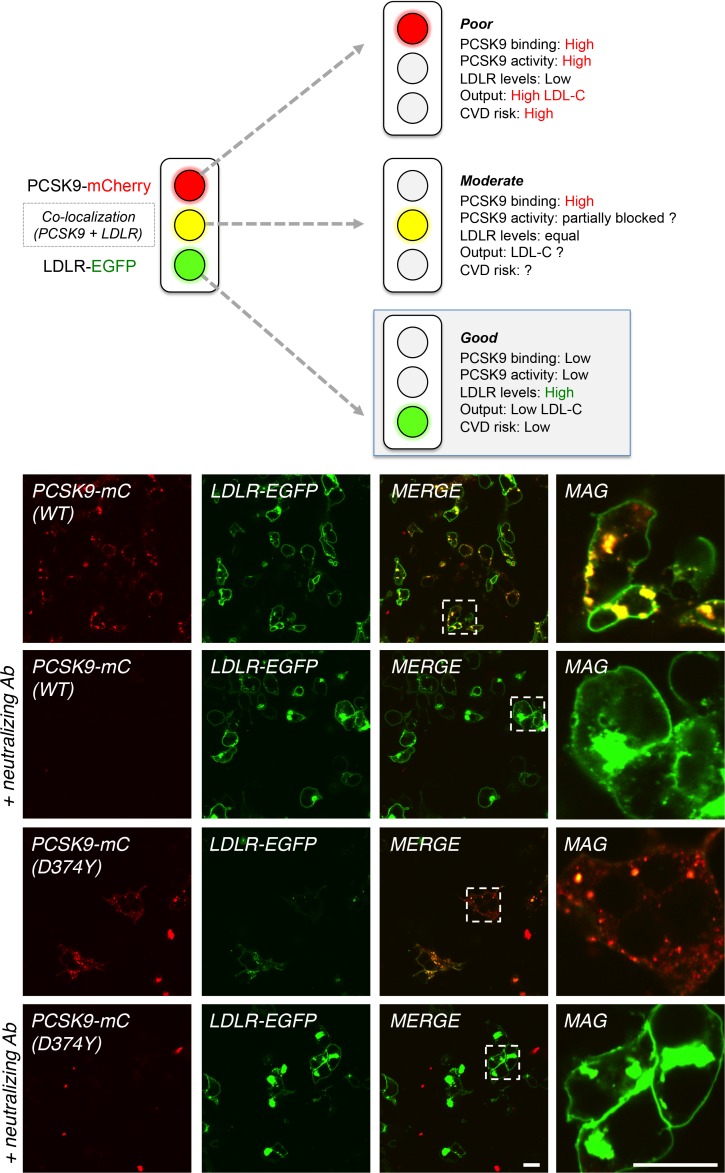
Dual fluorescence cell-based assay using PCSK9-mC and LDLR-EGFP.Schematic representation of different readouts that could be obtained from PCSK9-mC and LDLR-EGFP co-expressing cells is shown (upper panels). HEK293 cells were transfected with LDLR-EGFP and incubated for 4 h with WT PCSK9-mC or PCSK9 D374Y-mC containing media obtained from transfected cells without or with 4 nM anti-PCSK9 neutralizing antibody pre-incubated overnight (lower panels). Selected regions (dashed squares) were digitally zoomed 5X (magnified images, MAG). Scale bars = 20 μM. Data are representative of at least three independent experiments.